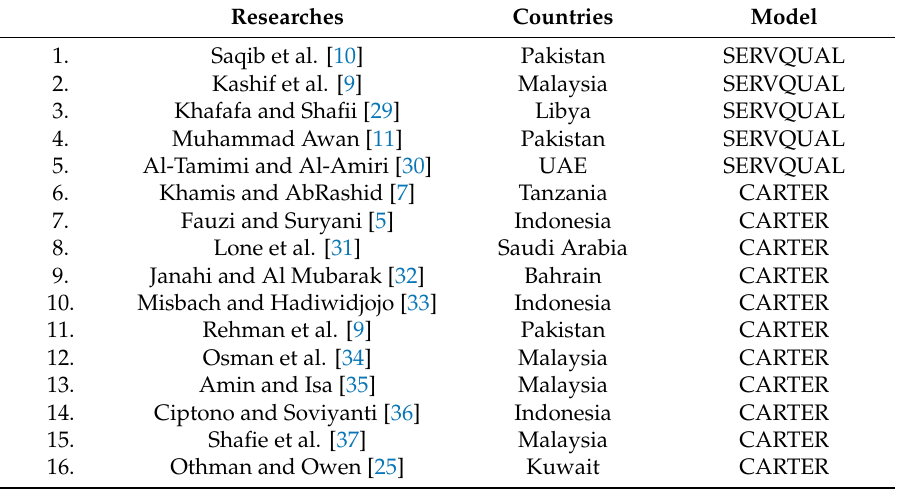
Table 1. SERVQUAL and CARTER models in the Islamic Banking